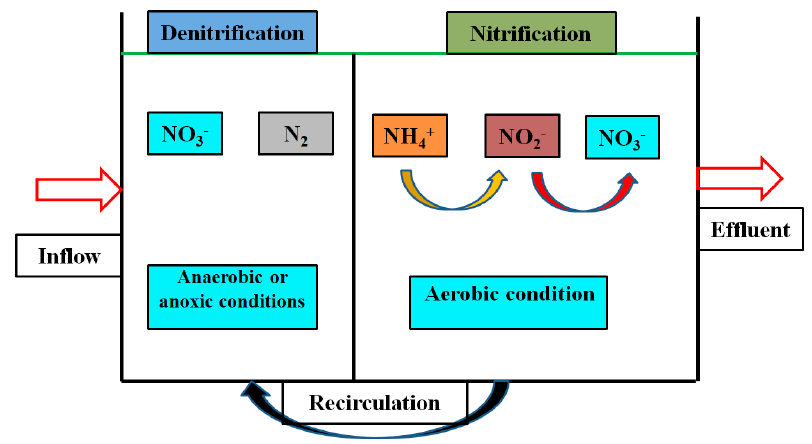
Figure 6. Biological nitrogen removal process.